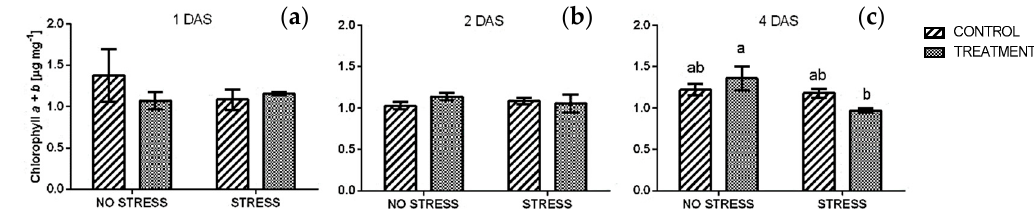
Figure 2. Chlorophyll content determined in vivo in rocket leaves treated with water (CONTROL) and with borage extract (TREATMENT) and subjected to salt stress (200 mM). Measures were taken after one day ( a ), two days ( b ) , and four days ( c ) of stress. Values are means ± SE ( n = 11). Data were subjected to two-way ANOVA. Di ff erent letters, where present, represent significant di ff erences ( p < 0.05).